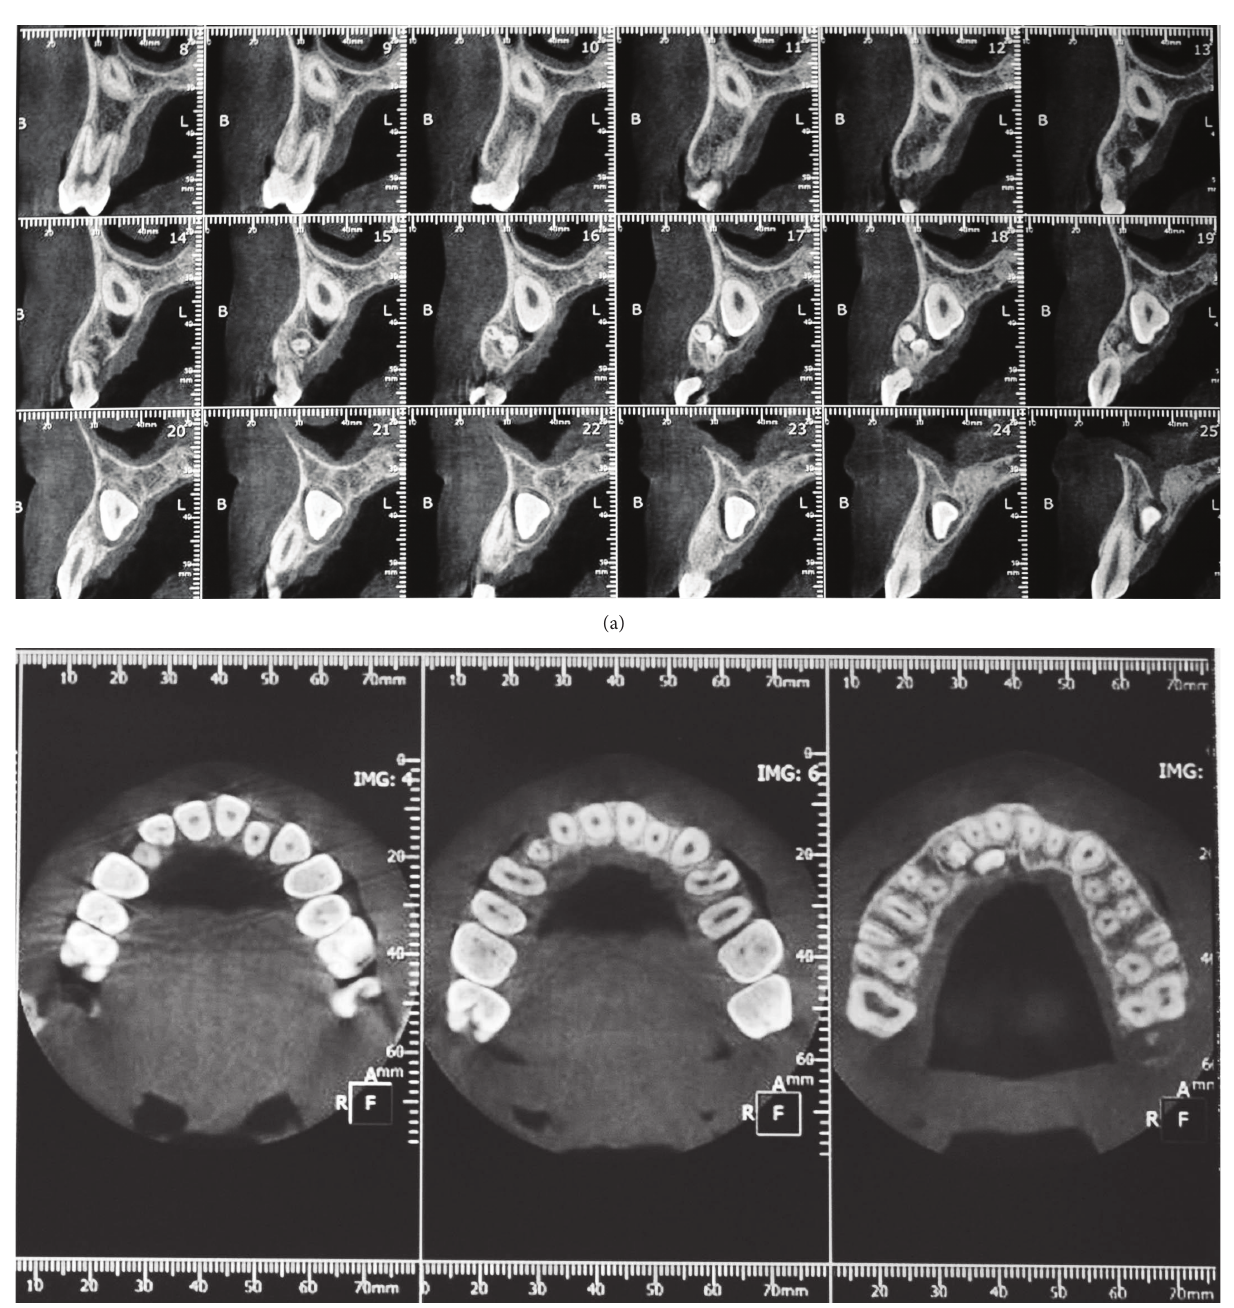
Figure 3: CT Dentascan: sagittal and axial